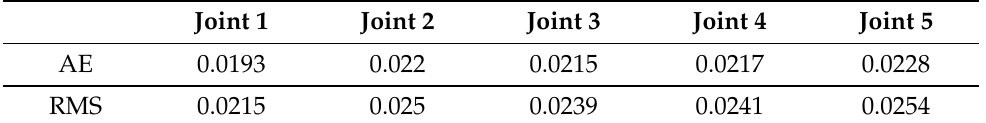
Table 5. Statistical analysis of LAC’s performance for each joint in RoM